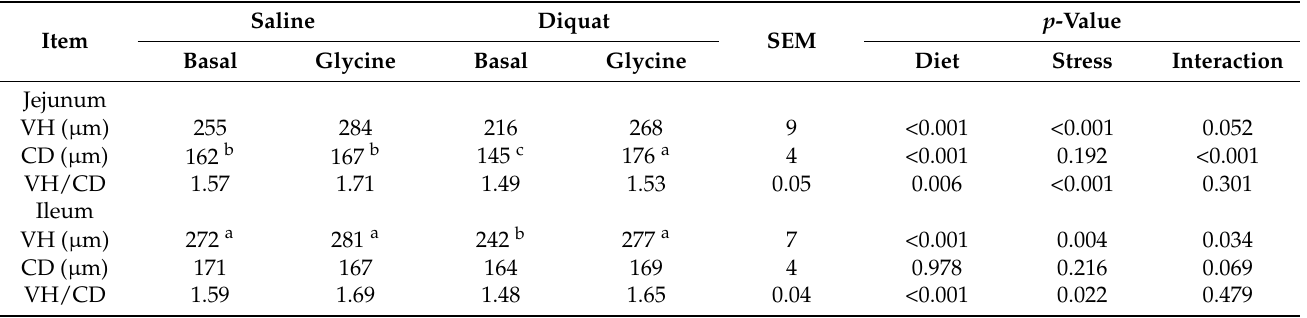
Table 2. The intestinal morphology of the piglets fed glycine diets under oxidative stress.